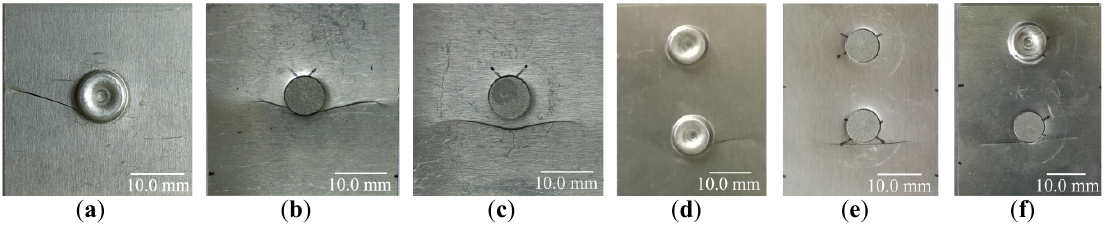
Figure 12. Fatigue failure modes of SPR joints. ( a ) SA; ( b ) AS-1; ( c ) AS-2; ( d ) SAT; ( e ) AST; ( f ) SAF.